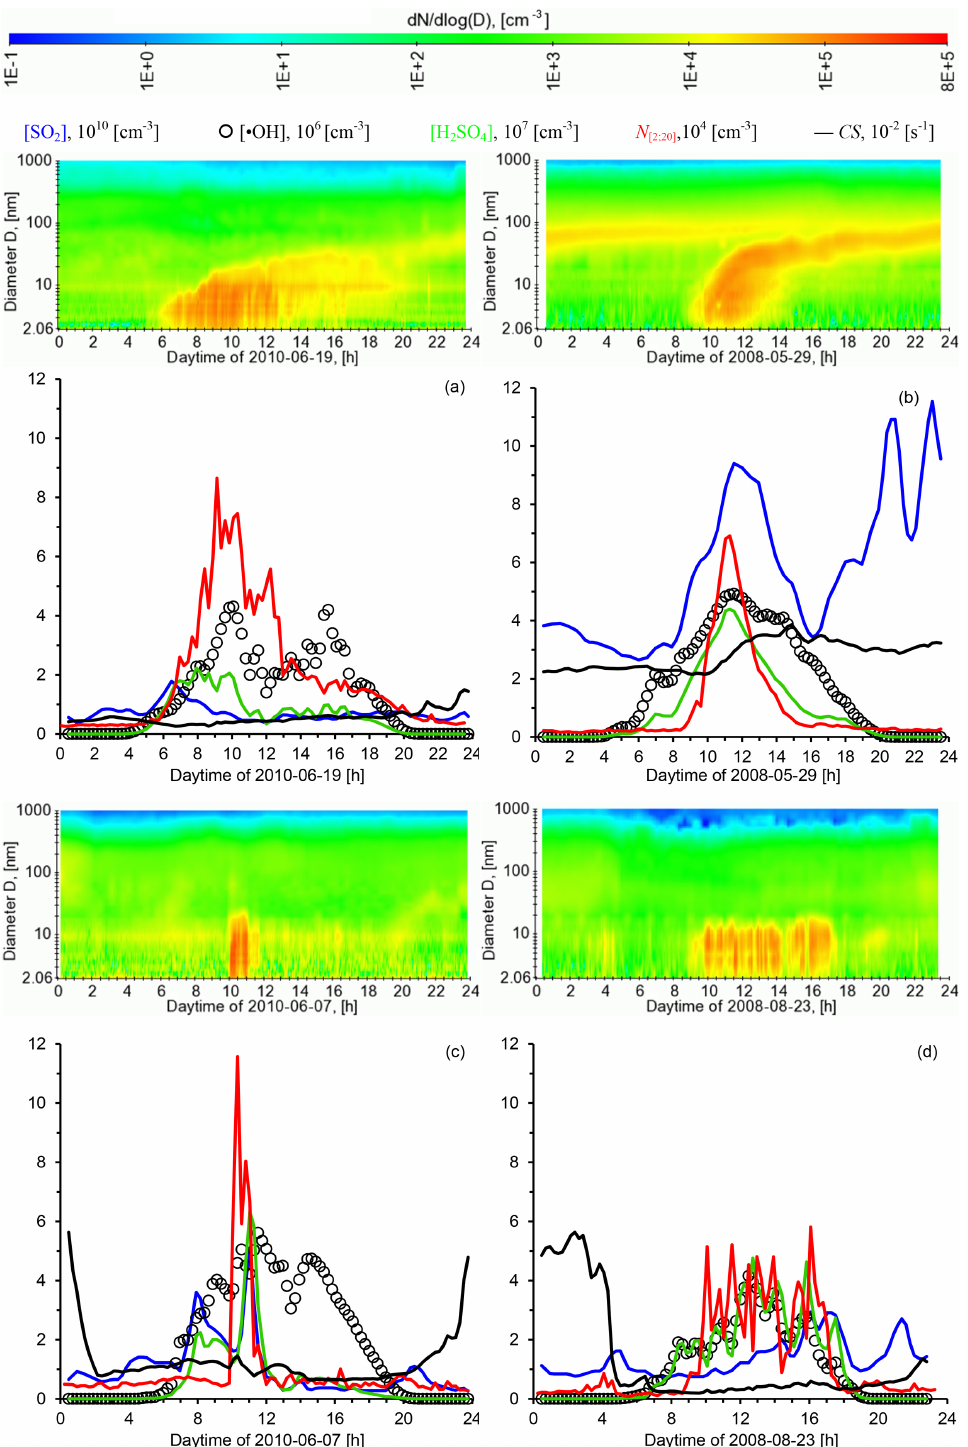
Figure 3. Time series of aerosol and gas-phase parameters during four exemplary NPF events: (a) 19 June 2010, (b) 29 May 2008, (c) 7 June 2010, (d) 23 August 2008. Shown are particle number size distributions, the concentrations of sulfur dioxide SO 2 , the hydroxyl radical sulfuric acid H 2 SO 4 , ultrafine particle number N [2;20] , and the condensational sink CS.